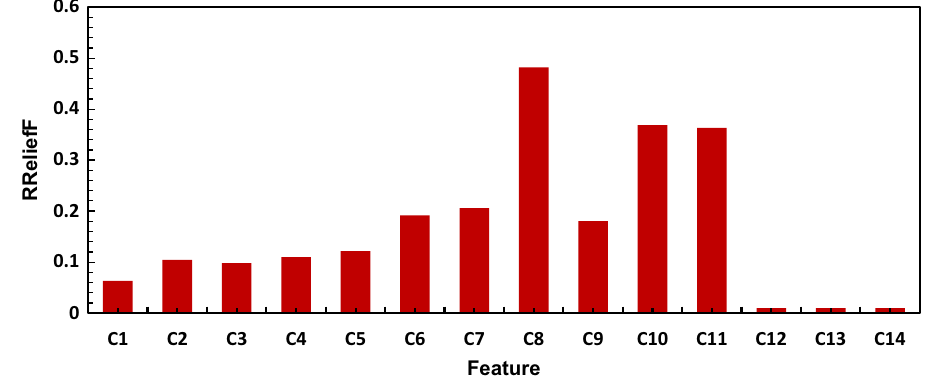
Figure 3. Ranking the importance of the predictors using RReliefF algorithm to find a subgroup of high- prevalence